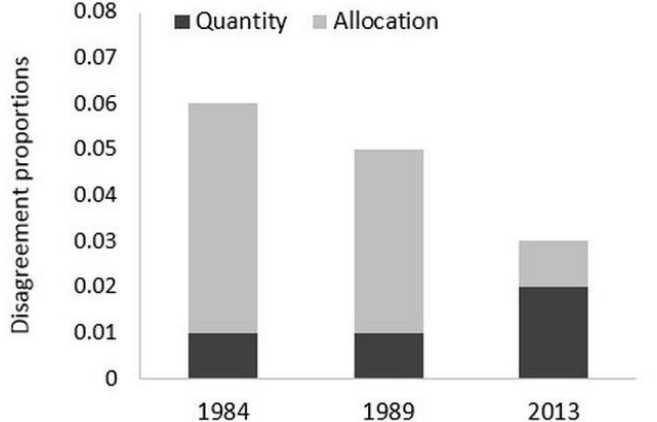
Figure 5. Quantity and allocation disagreement components estimated for each classification. The components are expressed as proportions of burned and unburned